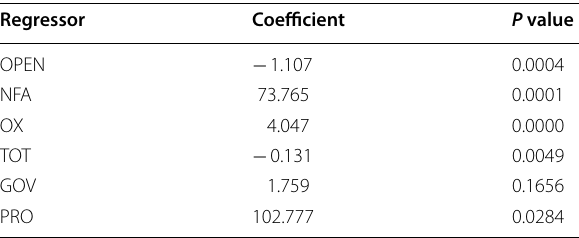
Table 4 Estimated long-run coefficients based on the